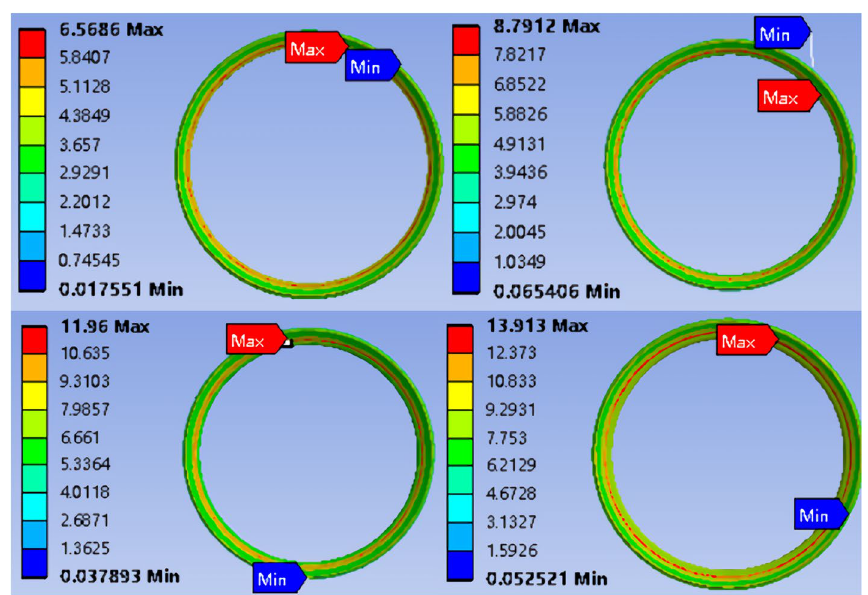
Fig. 34 B Pipe inner surface